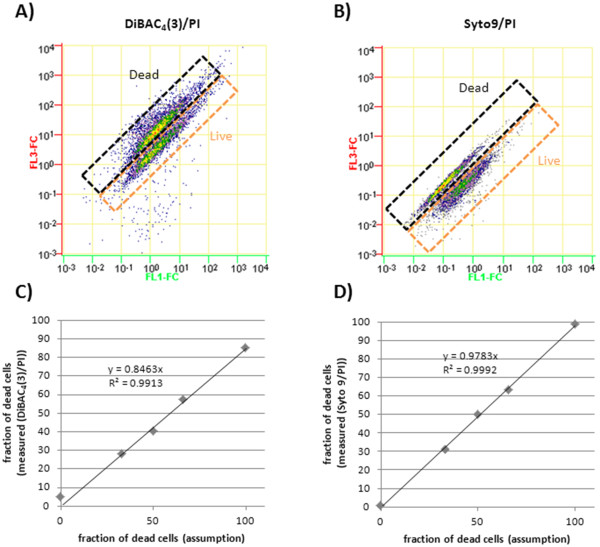
Viability estimation. Live/dead test of B. megaterium cells producing ABF D1.3 scFv with different dye combinations of DiBAC4(3)/PI and Syto9/PI. A) DiBAC4(3)/PI stain: 50% dead cell, 50% live cell mixture, B) Syto9/PI stain: 50% dead cell, 50% live cell mixture. C), D) Calibration curves were determined via different mixtures of dead (heat killed) and live (exponential phase) cells.